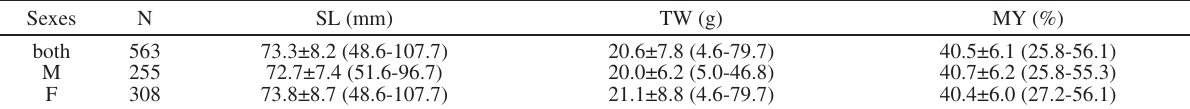
Table 1. – Descriptive statistics of the samples and meat yield of the purple dye murex ( Bolinus brandaris ) from the Ria Formosa lagoon. M, males; F, females; N, number of individuals; SL, shell length; TW, total weight; MY (%), meat yield. Data presented as mean±SD and range (minimum – maximum).